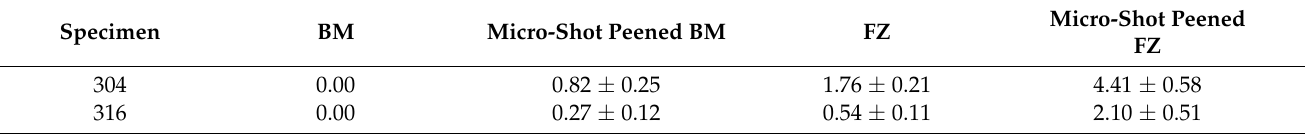
Table 2. The ferrite numbers of the tested samples determined by ferrite scope.